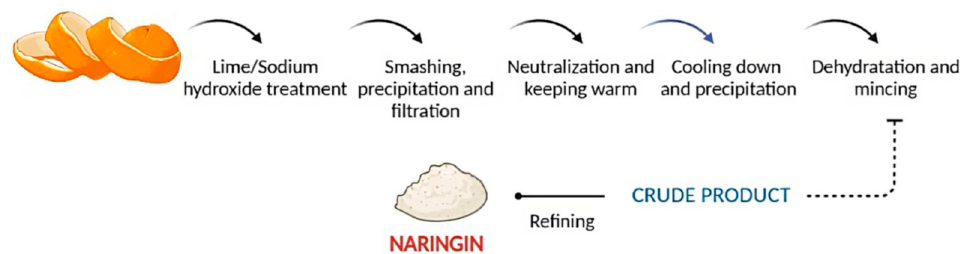
Figure 3. Steps in the naringin alkaline extraction process.